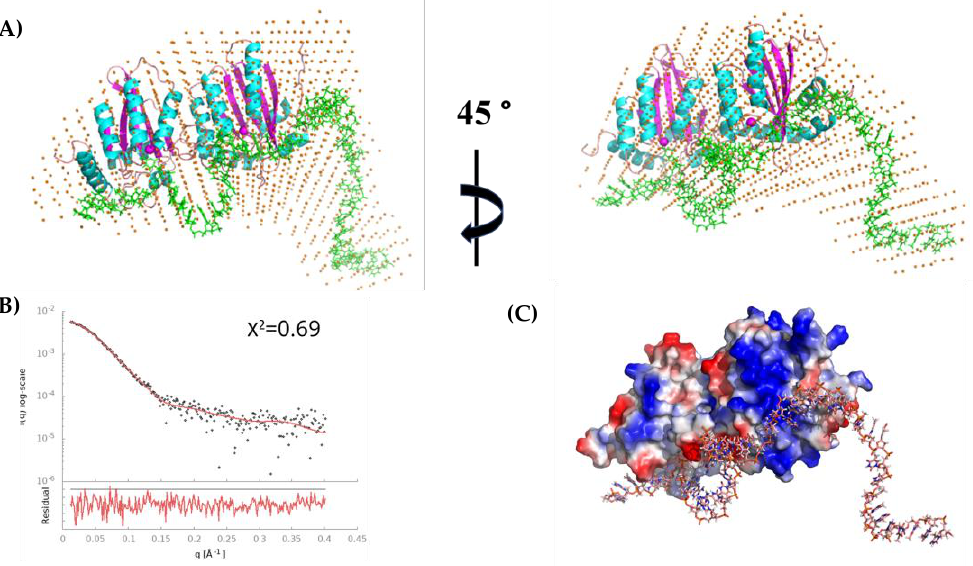
Figure 7. The model of CCdZ-T30-oligo in complex with monomer of A3G fl (Species-3). ( A ) Fit of model with SAXS-derived envelope (orange dots)_in two orientations. The CTD of A3G fl is on the left, the NTD is on the right; helices are shown in cyan, beta strands in magenta, loops in orange; the ssDNA is shown in green. ( B ) Fit (red solid line) of model with the SAXS profile (black dots), with residuals shown below. ( C ) The surface of the protein colored according to the charge distribution (red, negative; blue, positive) with CCdZ-T30-oligo superimposed (same orientation as right-hand frame of ( A ). The modeling was performed with PyMol (https://pymol.org/2/ (accessed on 18 August 2022)) using (1) the homology model (developed with YASARA (http://www.yasara.org/ (accessed on 18 August 2022)), using wild-type human sequence modeled onto full-length monomer from 6P40 [33], (2) the catalytically active C-terminal domain of A3G in complex with ssDNA 6BUX34 and (3) one DNA strand from B-DNA. The A3G-CTD/DNA complex (derived from 6P40) was used instead of free CTD in A3G fl structure, and the single-stranded DNA was elongated from 9 nucleotides in the original structure to 40 nucleotides in our experiments. Zinc atoms in active and pseudo-active sites are shown as magenta spheres in ( A